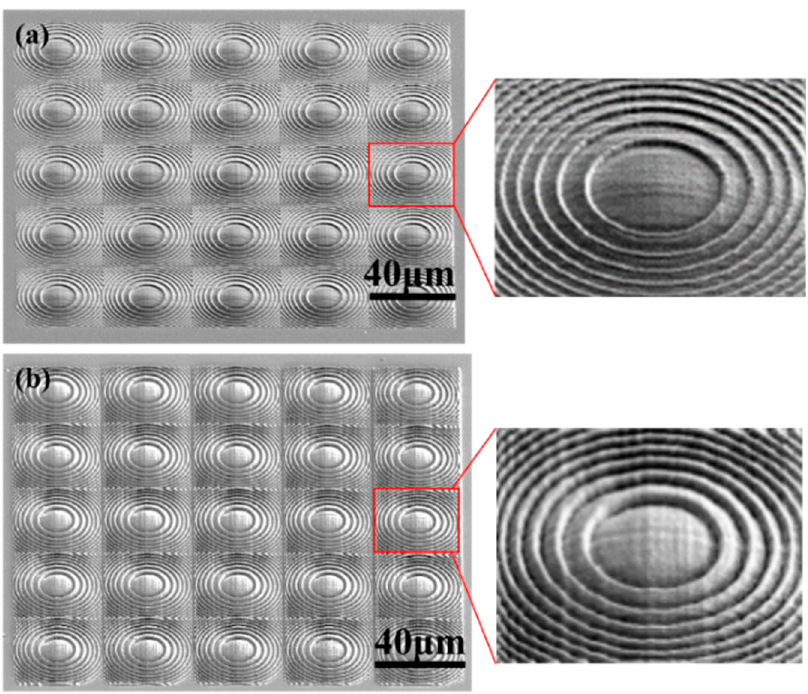
Figure 4. The 45° side view SEM image of the lens array annealed at ( a ) 120 °C and ( b ) 130 °C, respectively. The inset shows the magnified image of one lens in the array.